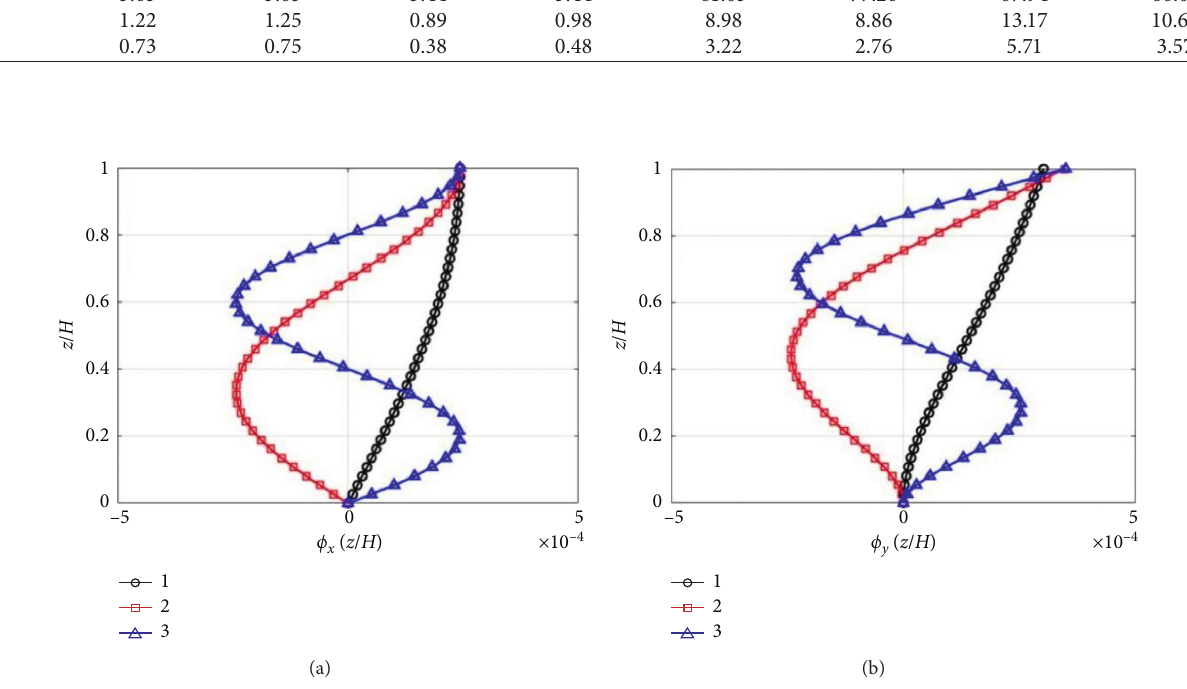
Figure 9: Mode shapes of the fixed-base building: CSF model without PDAs. (a) xz plane. (b) yz